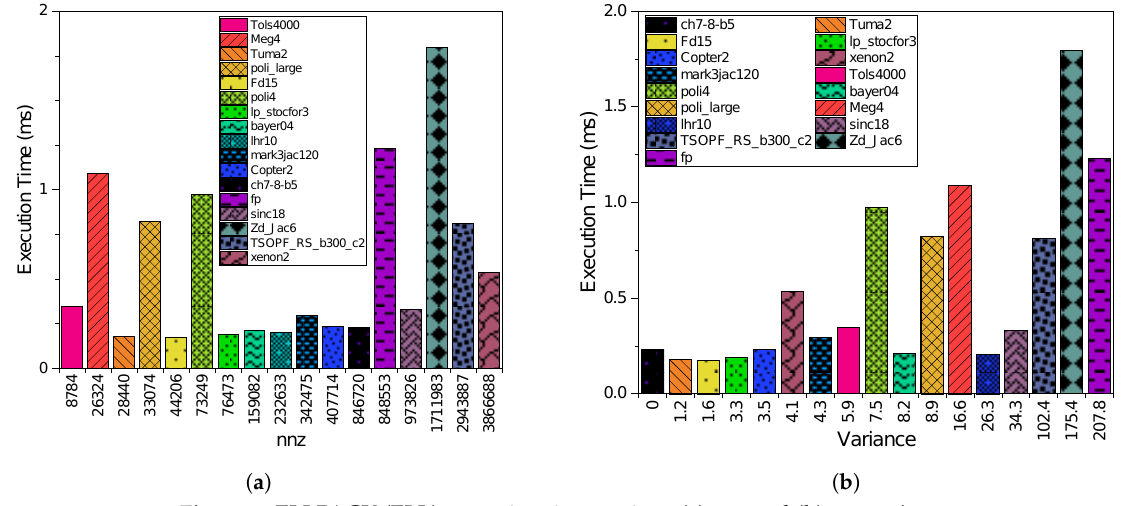
Figure 6. ELLPACK (ELL) execution time against: ( a ) nnz and ( b ) npr variance